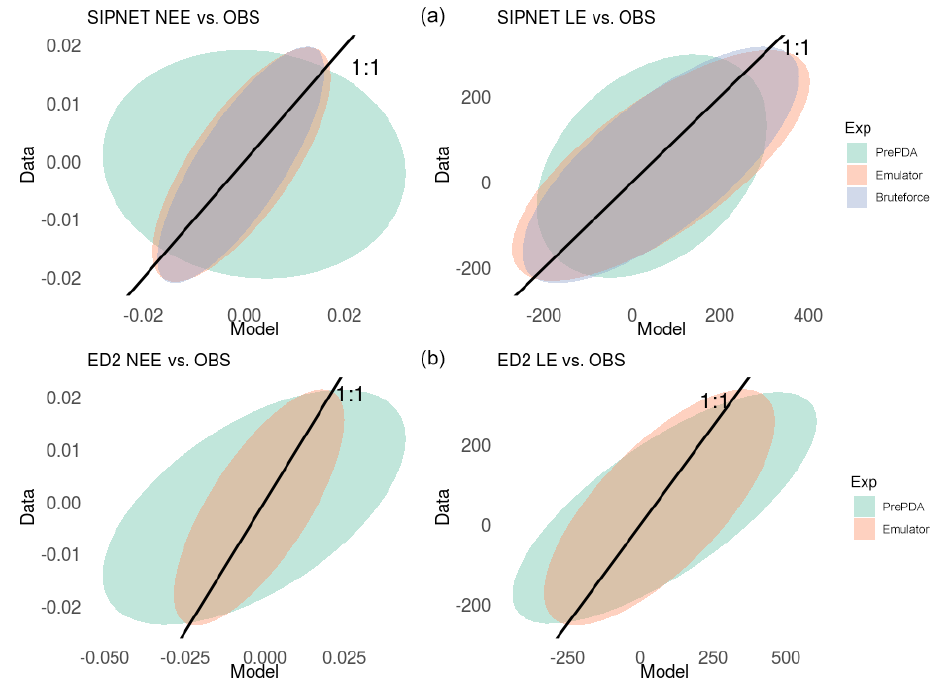
Figure A2. Predicted vs. observed comparison with concentration ellipses. (a) SIPNET; (b) ED2. Units are the same as in Fig. A1: NEE: kgCm − 2 day − 1 ; LE: Wm − 2